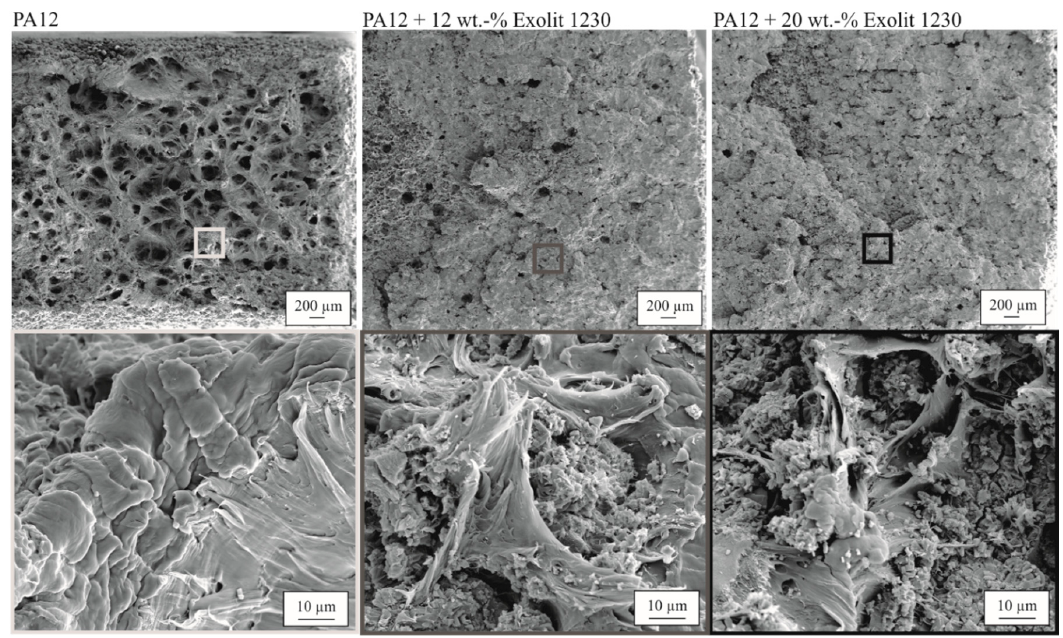
Figure 15. Fracture surface after tensile testing for specimens with different flame retardant Fracture surface after tensile testing for specimens with di ff erent flame retardant concentrations and an energy density of 0.35 J/mm³. concentrations and an energy density of 0.35 J / mm 3